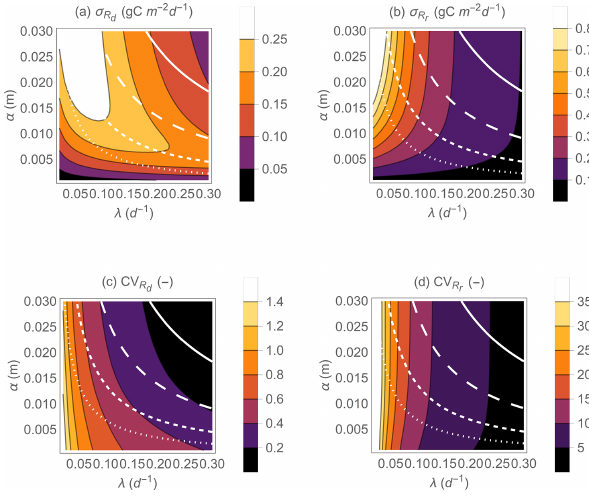
Figure 5. Effect of precipitation statistical properties (mean event frequency λ and depth α ) on the mean heterotrophic respiration rates during dry periods (cid:104) R d (cid:105) (a) and at rewetting (cid:104) R ∗ r (cid:105) (b) , the mean total respiration rate (cid:104) R t (cid:105) (c) , and the fraction of the total het- erotrophic respiration rate due to rewetting pulses (cid:104) R ∗ r (cid:105) / (cid:104) R t (cid:105) (d) . The white contour curves indicate combinations of λ and α that generate different annual precipitation rates ( (cid:104) P (cid:105) = αλ = 0 . 25, 0.5, 1, and 2myr − 1 from dotted to solid lines). Other parameter values: